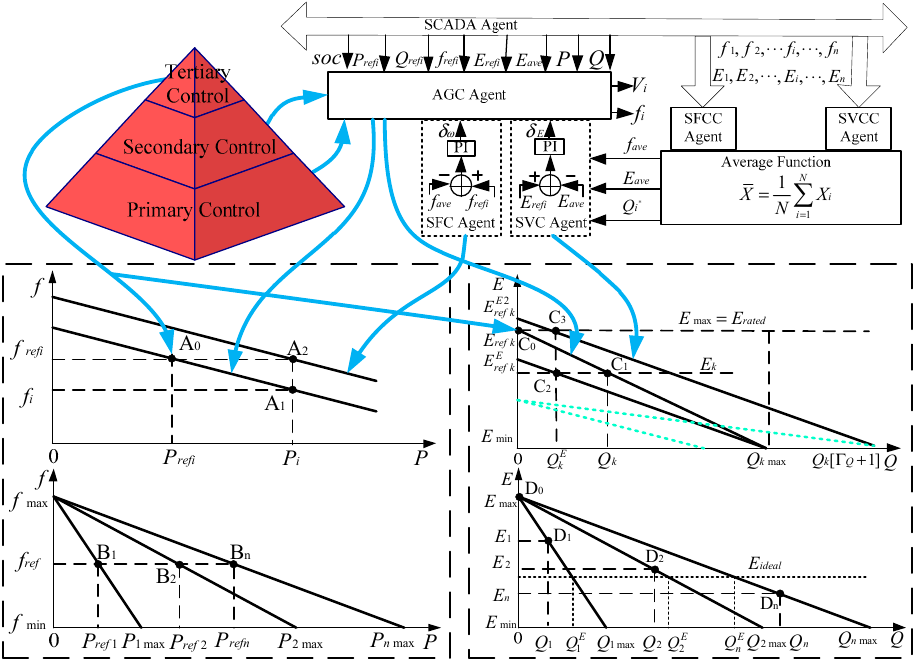
Figure 5. Distributed primary and secondary control algorithms.